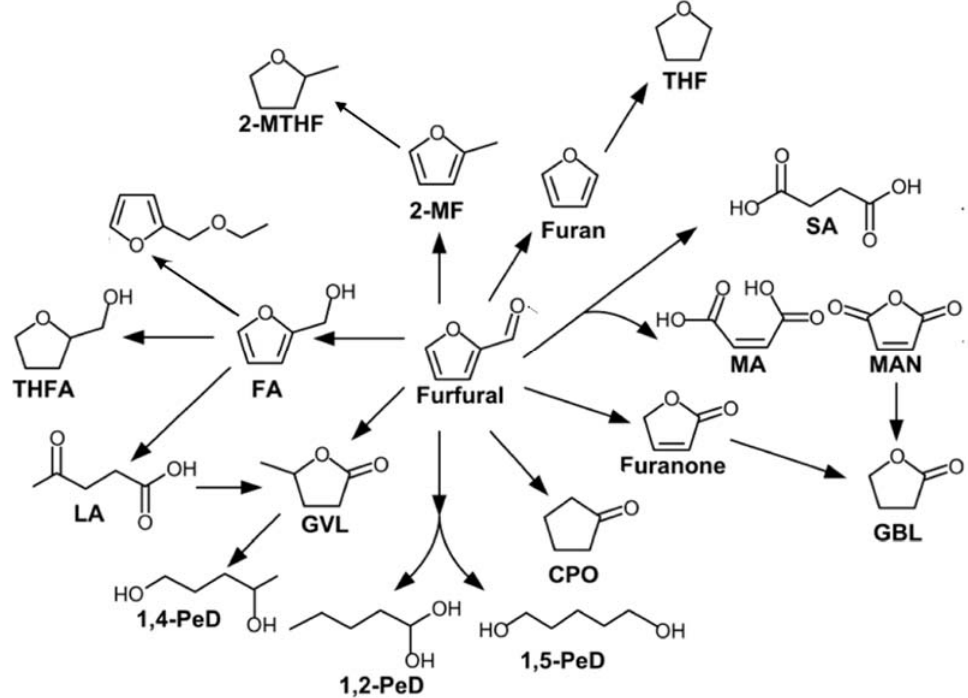
Figure 2. Examples of furfural-derived chemicals and biofuels. Adapted from Ref. [70]. Copyright Year 2016, American Chemical Society.